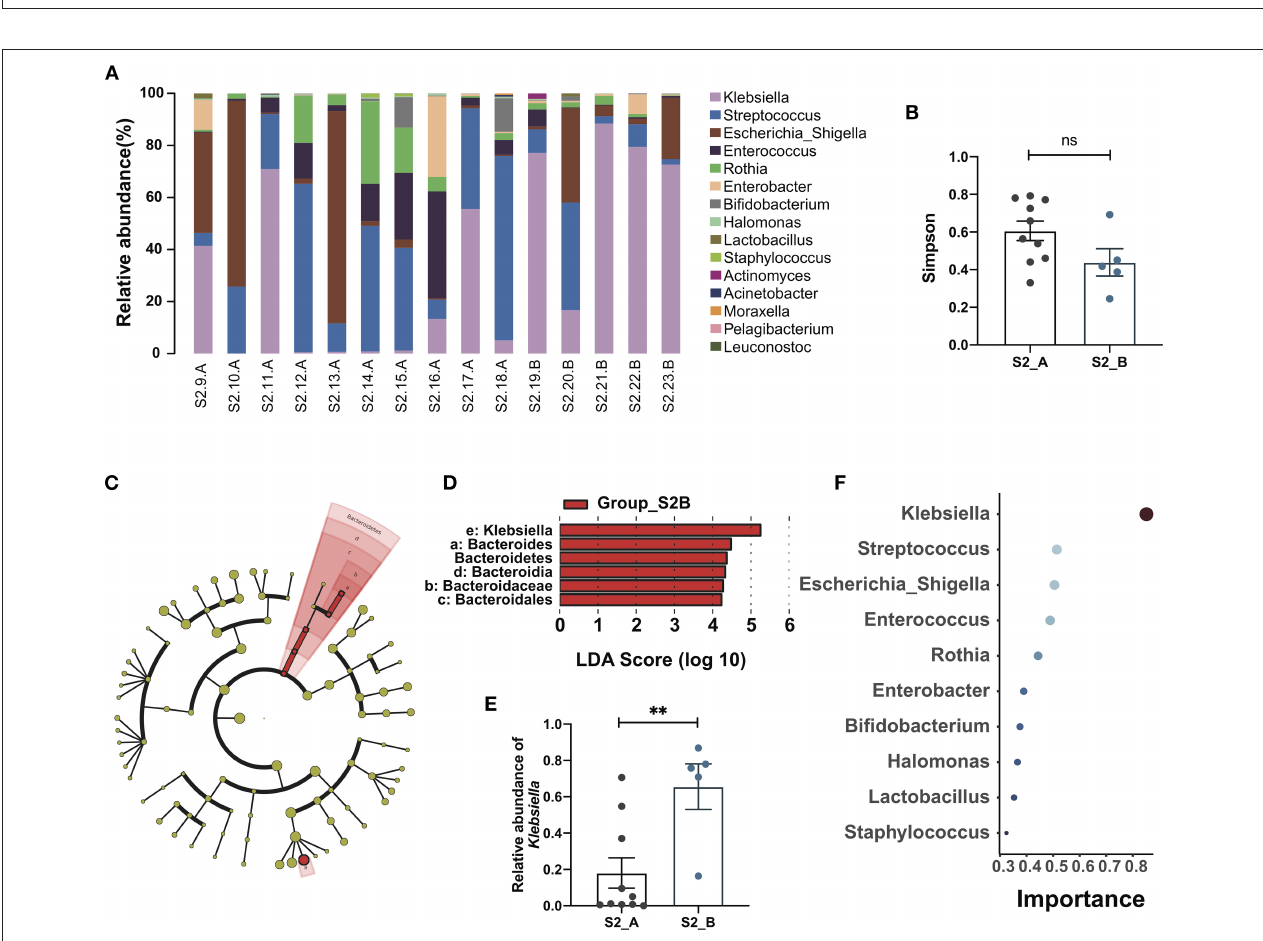
FIGURE 1 | Binary Jaccard distances in patients before (Group_S1, n = 16) and after (Group_S2, n = 23) Kasai surgery. Each point represents a sample. Similar samples cluster together. There was a significant difference between the two groups (ADNOIS test). (D) Bar plot showing the relative abundance of the top 15 genera in each sample. (E) Cladogram of LEfSe analysis, showing the differential abundance between the two groups. Different colors represent different groups. Red nodes, microbiota with significantly higher abundance in Group_S1. Green nodes, microbiota with significantly higher abundance in Group_S2. Yellow nodes, microbiota with no significant difference between the two groups. Node size indicates relative abundance. Numbers are annotated in (F) . (F) Bar plot showing 10 differential taxa in each group ranked by LDA score. (G,H) Bar plots showing the relative abundance of Bifidobacterium and Klebsiella in both groups (Group_S1, n = 16; Group_S2, n = 23). The significance of differences was assessed by Mann-Whitney test. * p < 0.05; ** p < 0.01; **** p < 0.0001.